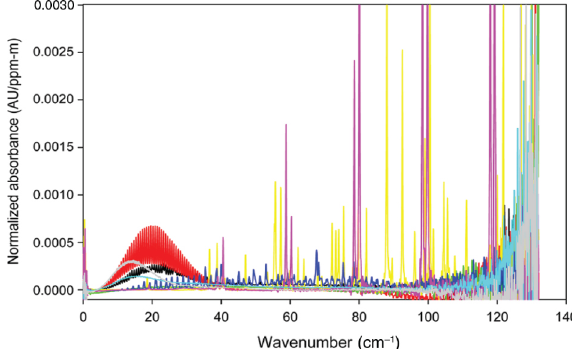
Figure 3: Expanded view of absorbance for THz spectra of acetaldehyde (black), acetonitrile (red), ethanol (green), water (yellow), methanol (blue), ammonia (magenta), propionaldehyde, propioaldehyde (cyan), and propanenitrile propioni- trile